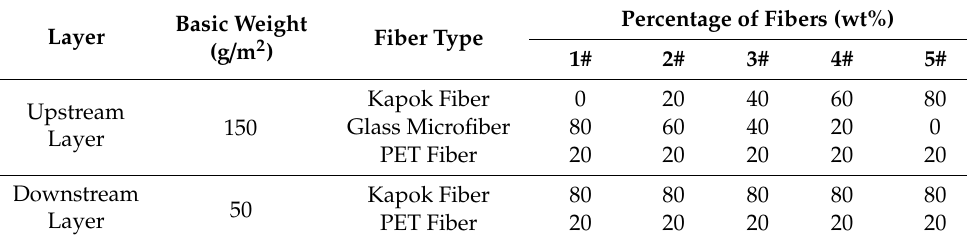
Table 2. The percentage of different fibers in filter media.